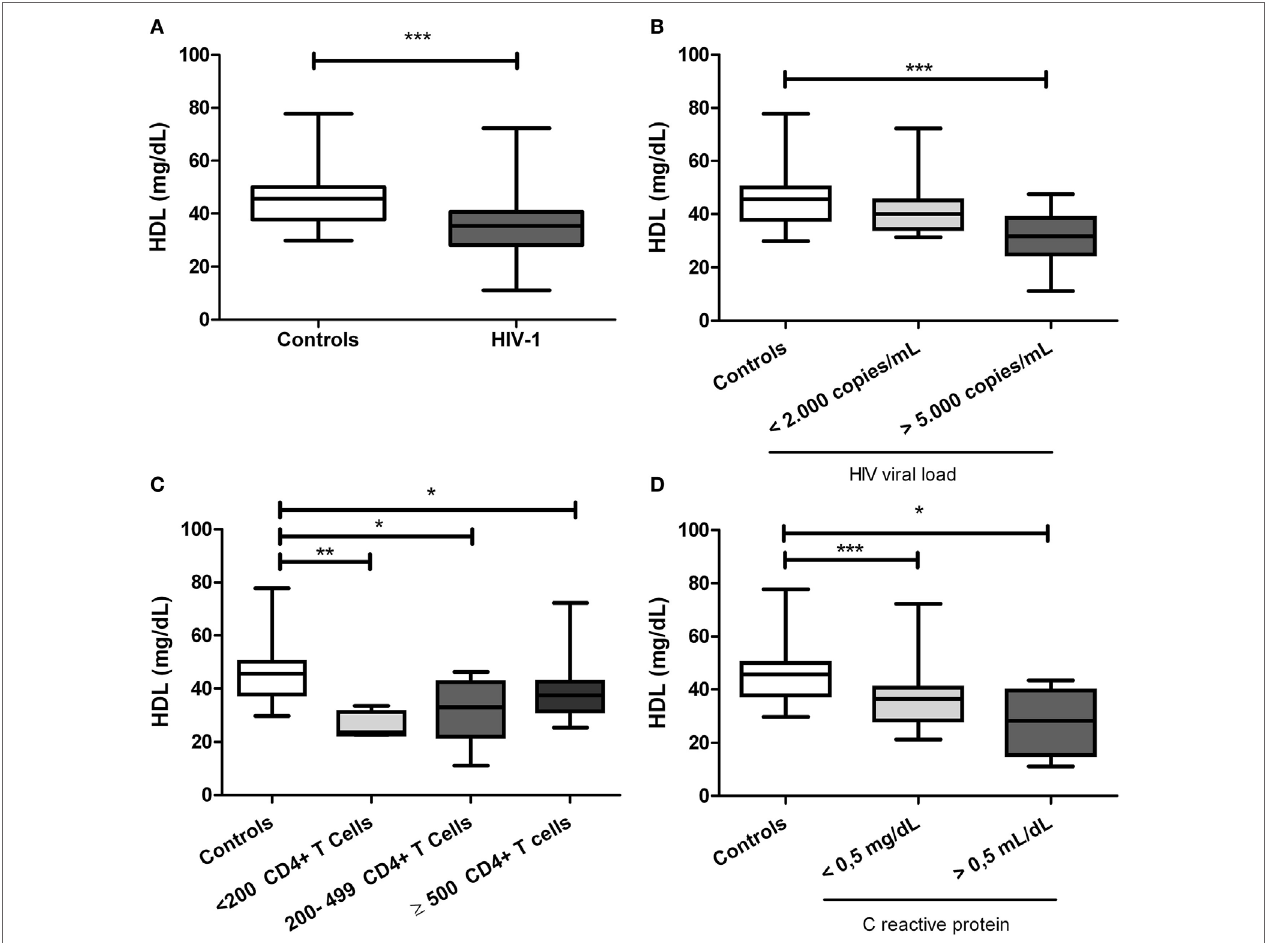
FigUre 1 | Serum high-density lipoprotein (HDL) levels in human immunodeficiency virus type 1 (HIV-1)-infected individuals and healthy controls. (a) HIV-1-infected individuals and healthy controls. In addition, HIV-1-infected individuals were classified according to (b) viral load, (c) CD4 + T-cells counts, and (D) C-reactive protein levels. The statistical comparison was made using Mann–Whitney U and Kruskal–Wallis tests with a 95% confidence level; and post hoc tests (or multiple benchmarks) HDS of Dunn was made. Significant differences are represented in the upper part of this figure (* p < 0.05; ** p < 0, 01; and *** p <